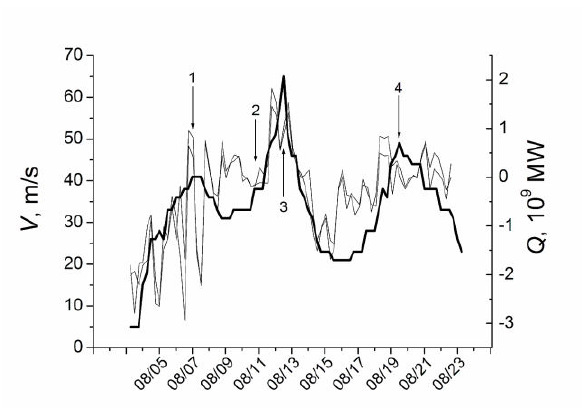
Figure 3. TC Alberto evolution: here and further on thick line – TC intensity V ; thin lines – advective latent heat fluxes Q